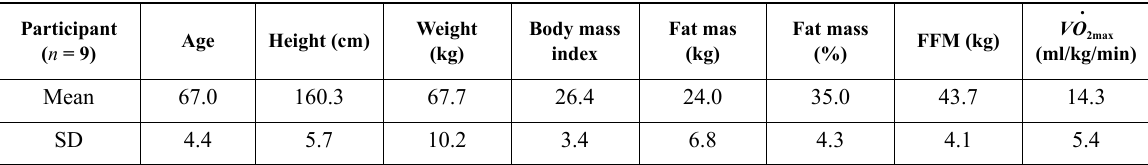
Table 1. Characteristics of